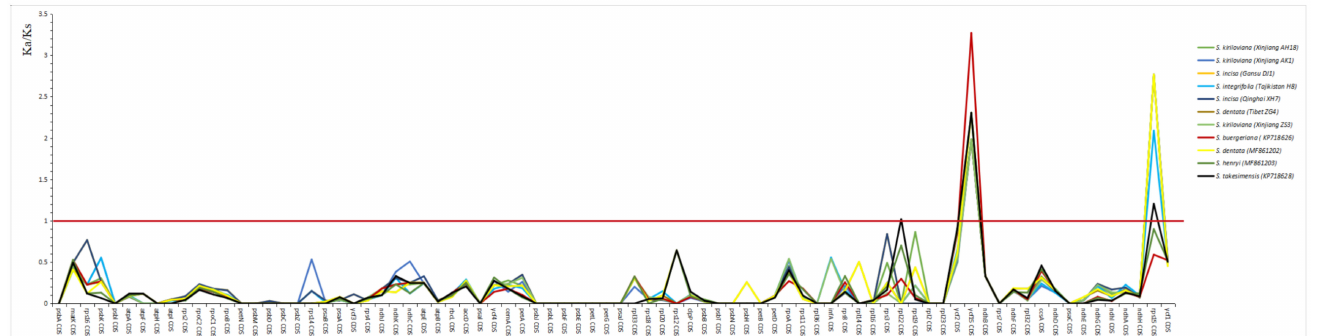
Figure 8. The Ka/Ks analysis of eleven individuals of Scrophularia